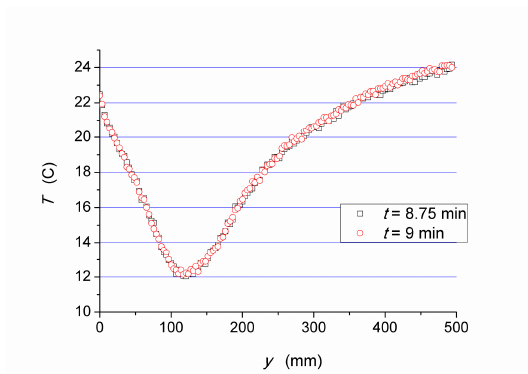
Fig. 5. Temperature distribution along the vertical line in a stationary state (after 8.75 and 9